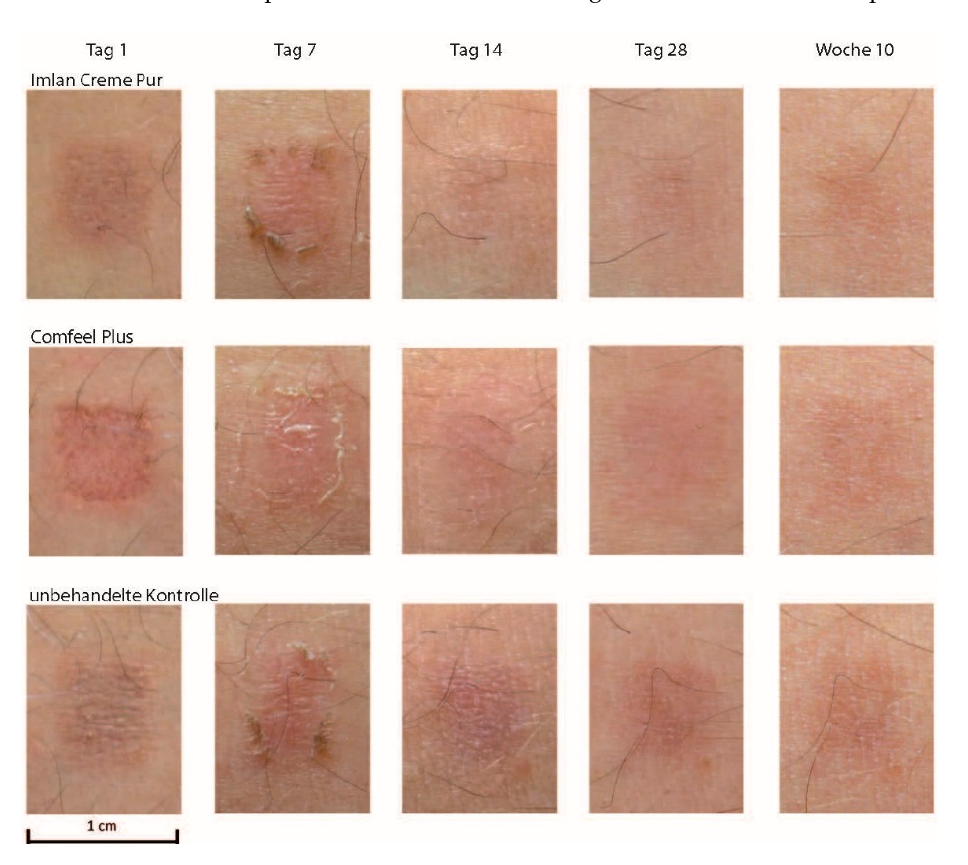
Figure 1. Scar formation of laser skin lesions treated by TBG, hydrocolloid or gauze (one of 50 cases presented). The columns (Tag 1, 7, 14, 28, Woche 10) show the status of healing at days 1, 7, 14, 28 and after 10 weeks, beginning at the left side with day 1 after making 3 laser skin lesions of similar size and depth. The lines (Imlan Creme Pur, Comfeel Plus, unbehandelte Kontrolle) show the 3 different methods of treatment of the 3 similar laser skin lesions, being TBG at the top line, hydrocolloid in the middle, and gauze at the bottom line.